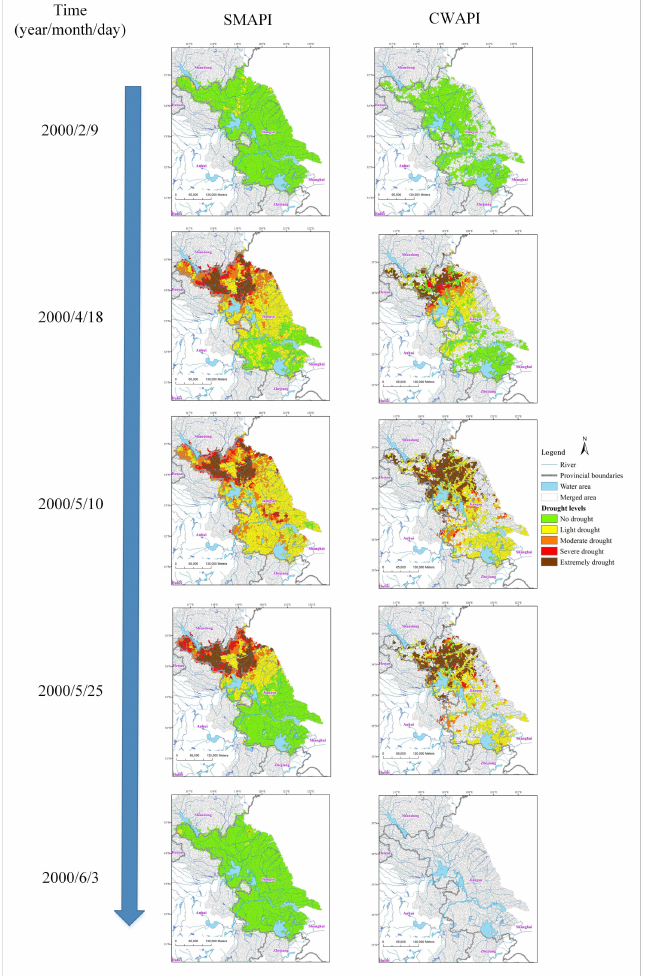
Figure 8. Spatial distribution of drought levels using SMAPI and CWAPI on 9 February, 18 April, 10 May, 25 May, and 3 June 2000 in a large-scale drought event in Jiangsu